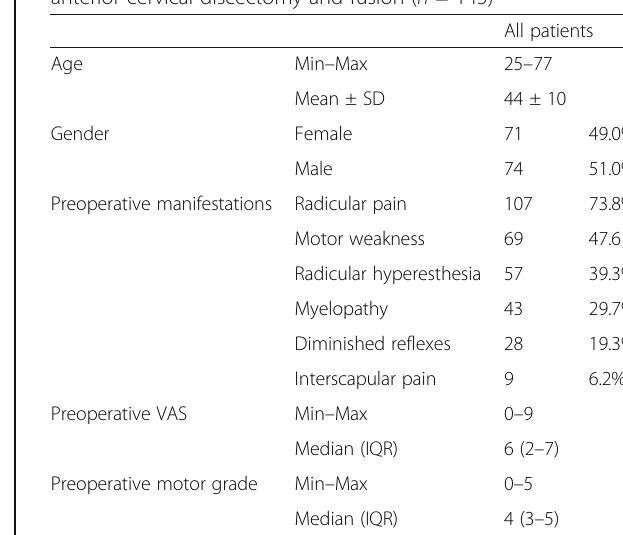
Table 1 Characteristics of the studied patients who underwent anterior cervical discectomy and fusion ( n =